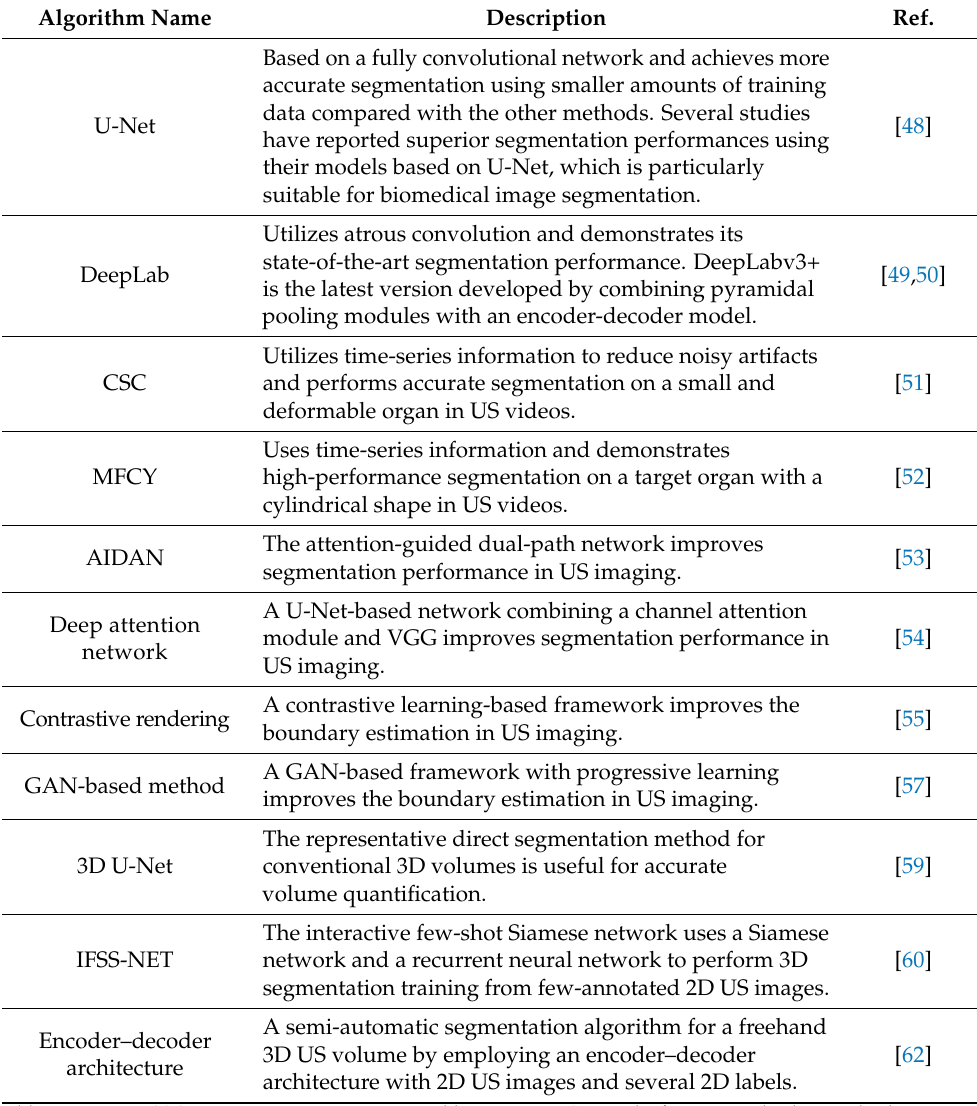
Table 2. List of segmentation algorithms for US imaging